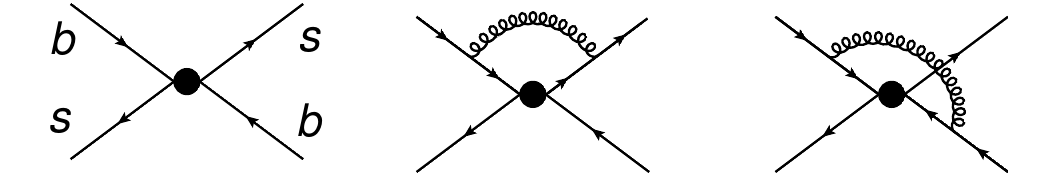
Figure 2 . Sample Feynman diagrams with ∆ B = 2